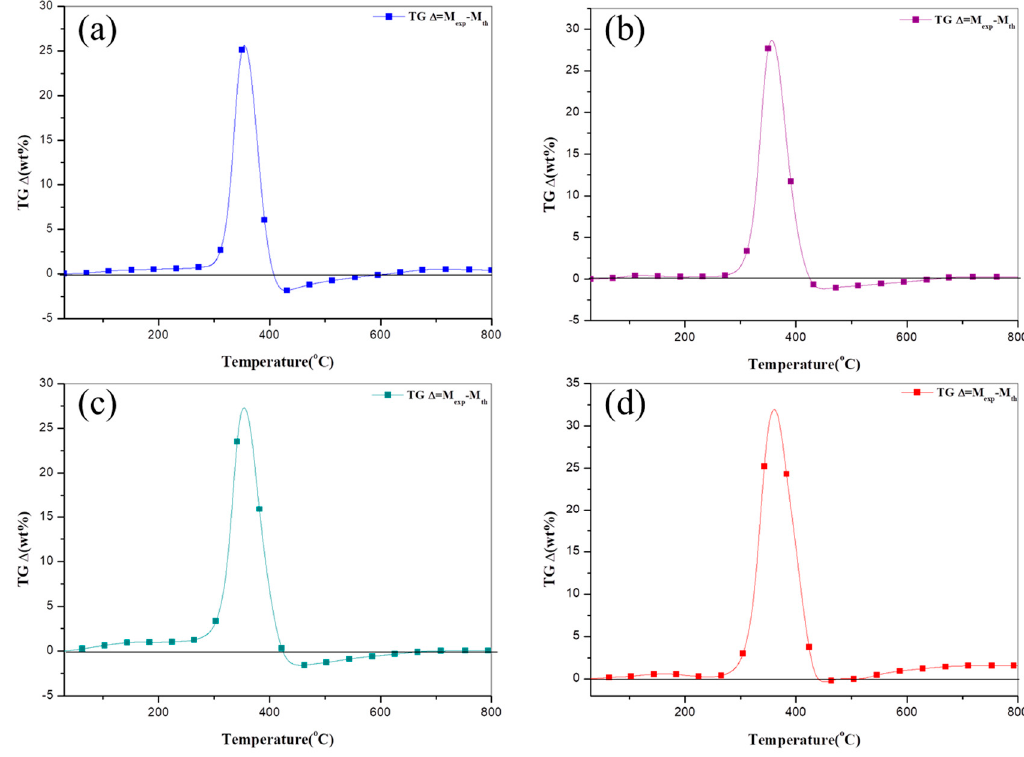
Figure 8. Dependence of the interaction TG Δ on the degradation time for PU/HBNPSi ( a ) 10%, ( b ) 20%, ( c ) 30%, and ( d ) 40%.